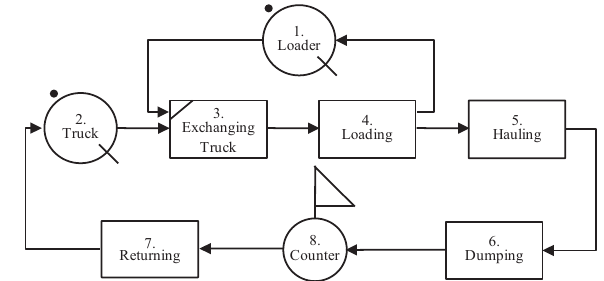
Fig. 3. Earthmoving operation model (adapted from Ahn